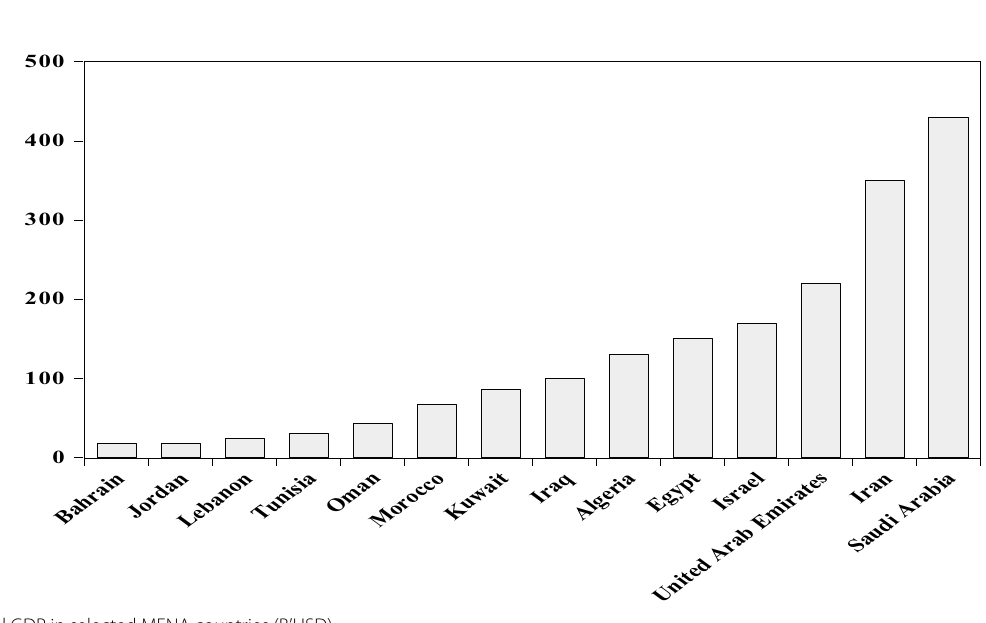
Fig. 3 Real GDP in selected MENA countries